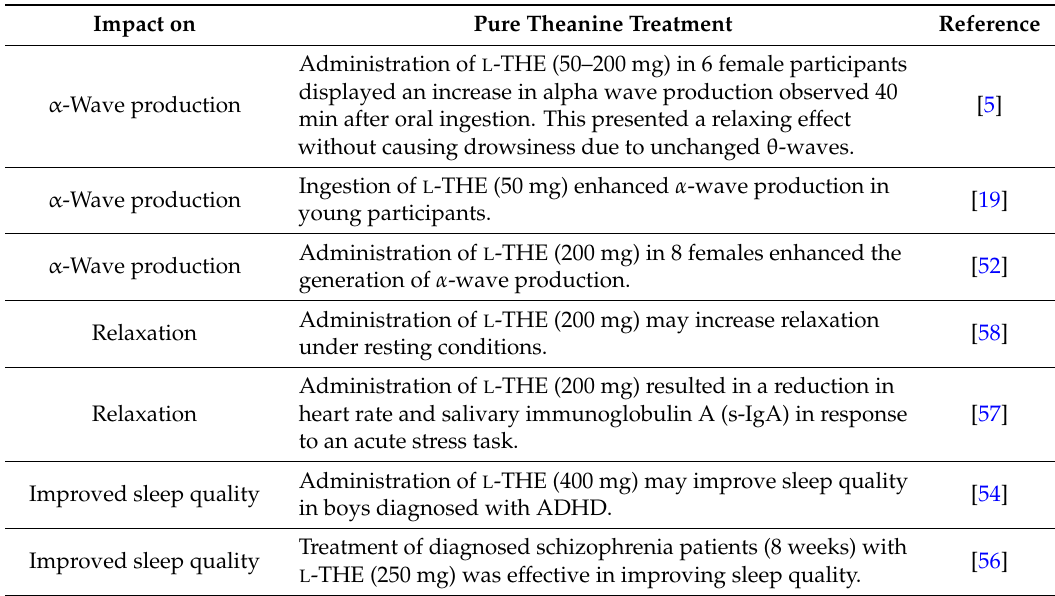
Table 1. The effect of pure L -THE consumption on generation of wave production and its patterns in the human